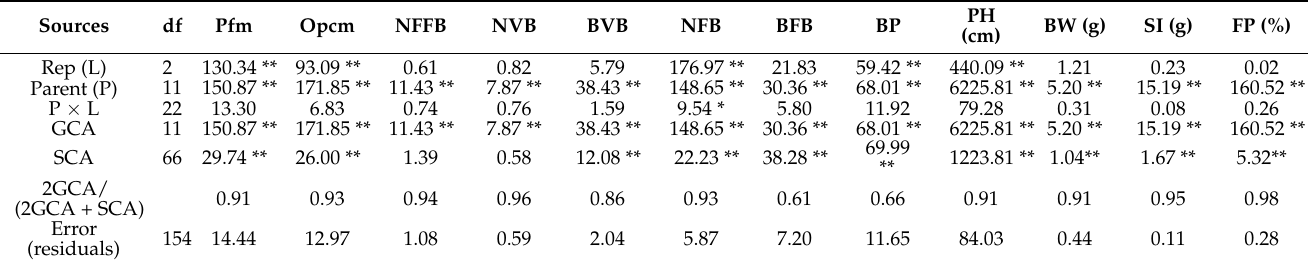
Table 2. Mean squares of the agronomic traits of 12 cotton lines originated from Burkina Faso and the United